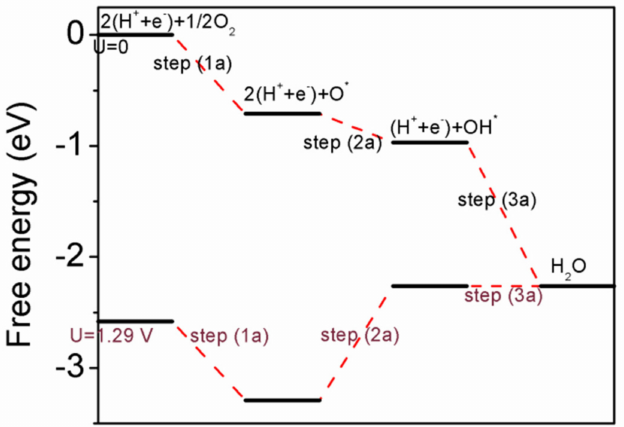
Figure 6. The free energy diagram for oxygen reduction on Pd/Pd–Cu(110) surface. It is noted that if the potential is higher than 1.29 V, step (2a) and step (3a) will become